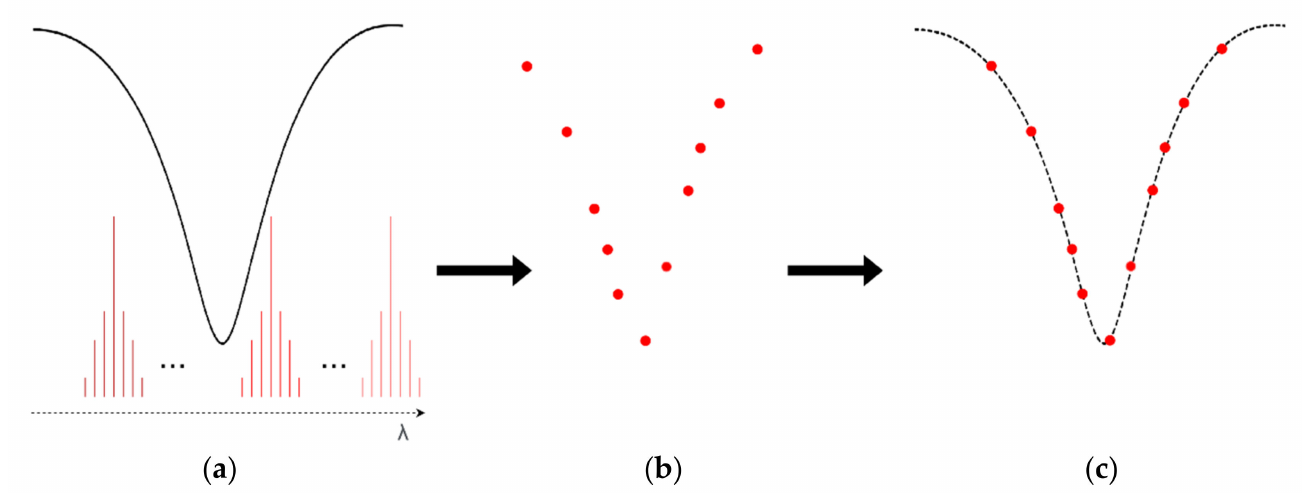
Figure 2. Operating principle of the developed interrogation system. ( a ): Spectral sweep by thermally tuning the laser’s wavelength; ( b ): Discrete spectrum resulting from the interrogation; ( c ): Reconstruction of the original spectrum by a curve fitting